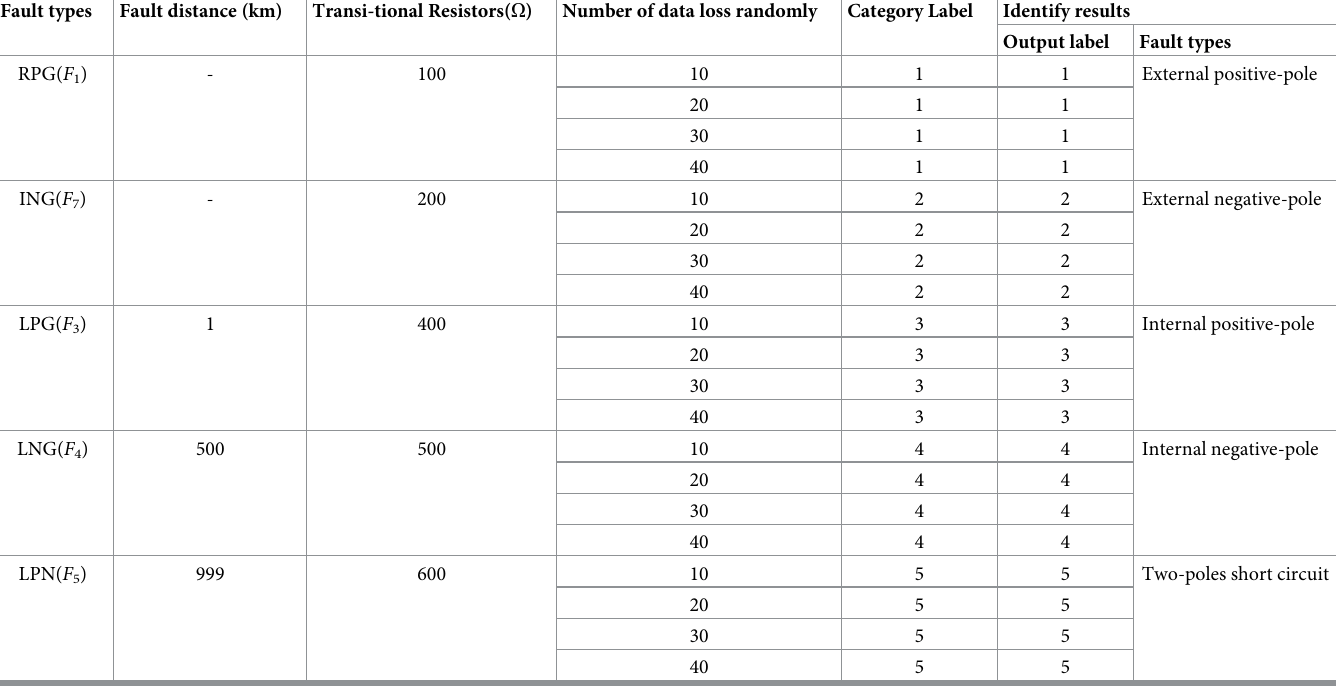
Table 8. Protection algorithm performance test when sampling point data is randomly